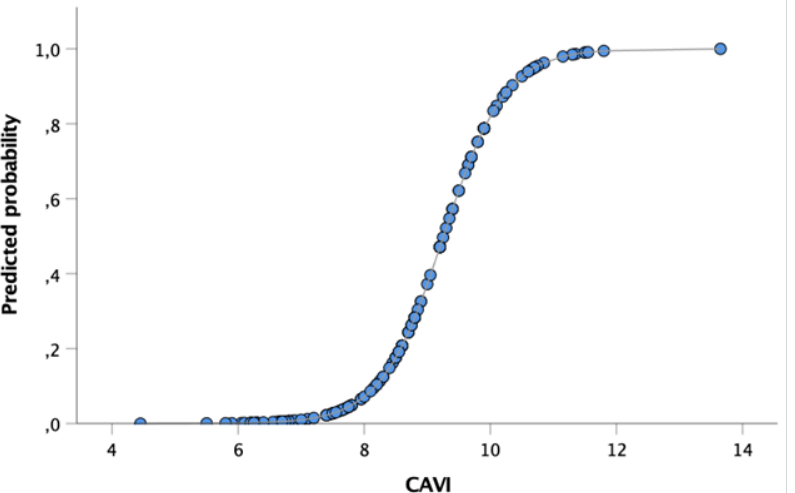
Figure 4. Predicted probability of high-risk echocardiography criteria of PAH at second observation (within 1 month from diagnosis) based on the CAVI value at PE diagnosis. Abbreviations: CAVI: cardio-ankle vascular index.